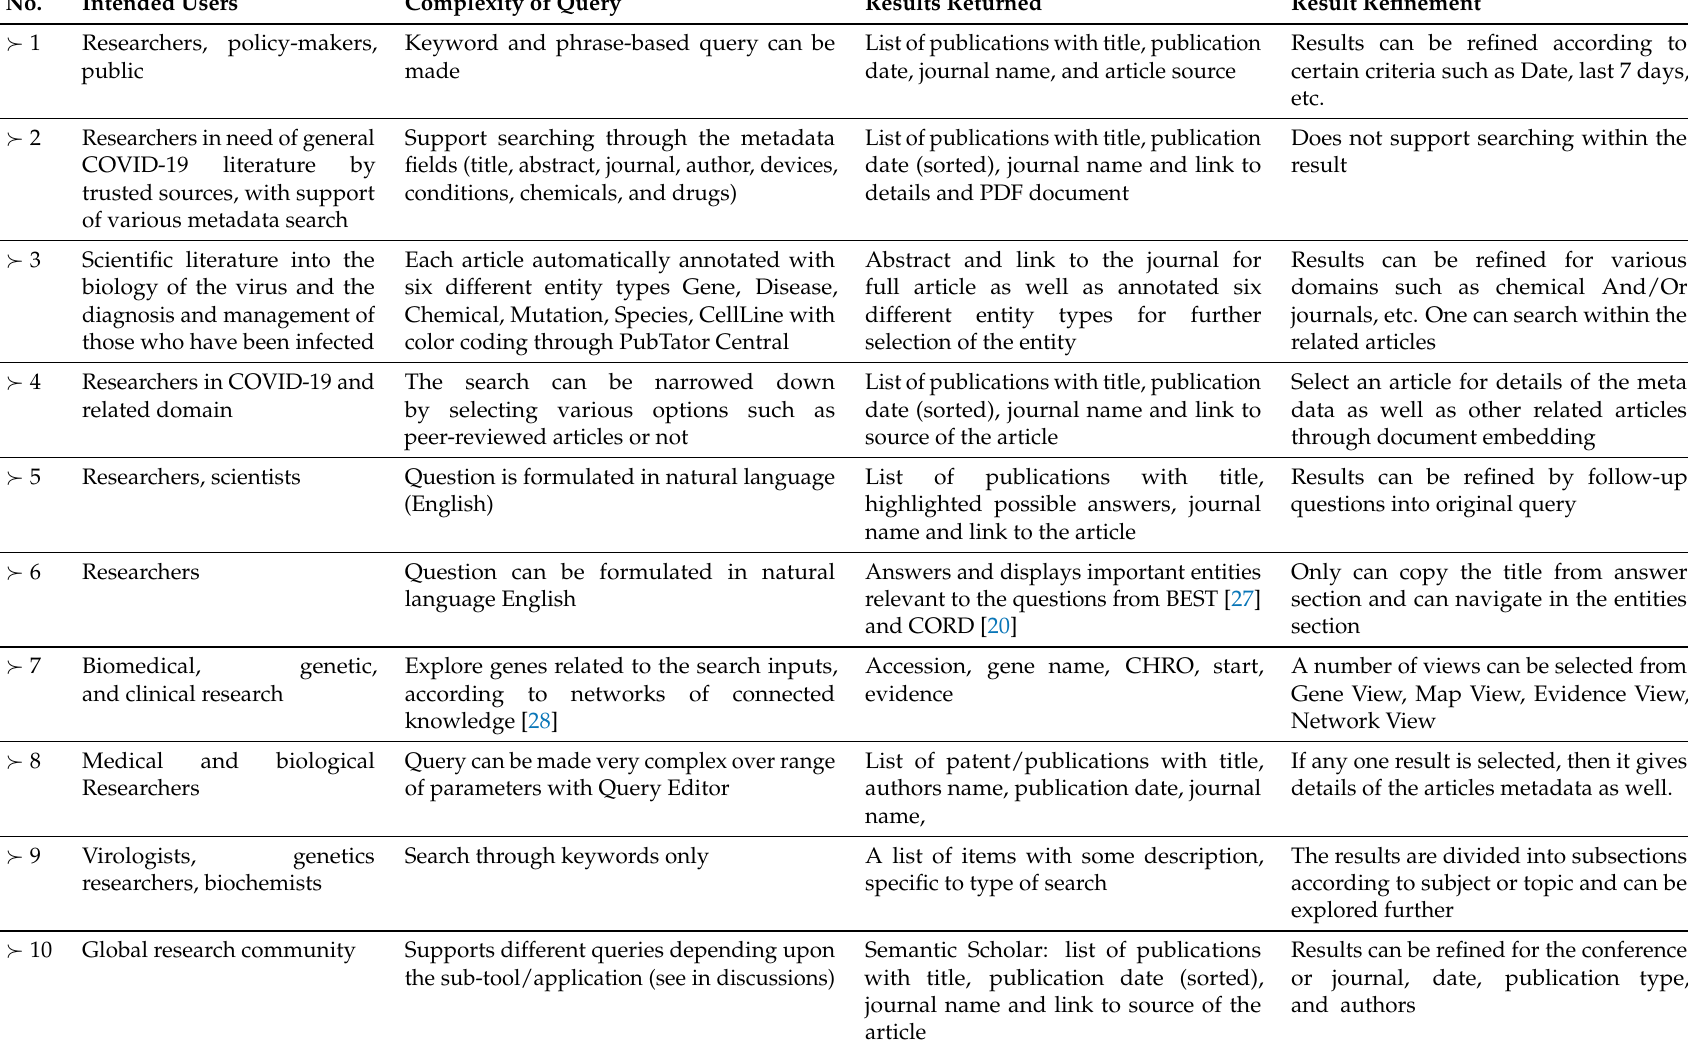
Table 2. Analysis of COVID-19 search portals using selected features (Part 2 of